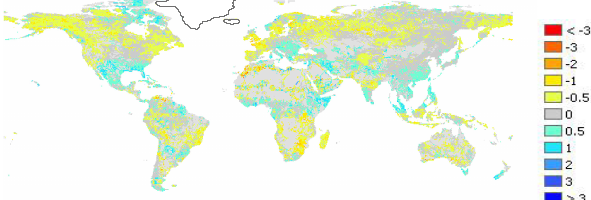
Fig. 5. Change in aridity. The division in humid and arid regions is obtained from the WWRDII climate moisture indices (UN, 2006). The globe is divided in humid regions becoming wetter (dark blue), humid regions becoming drier (light blue), arid regions becoming wetter (green) and arid regions becoming drier (yellow) based on the ensemble average change calculated for the A1B scenario.